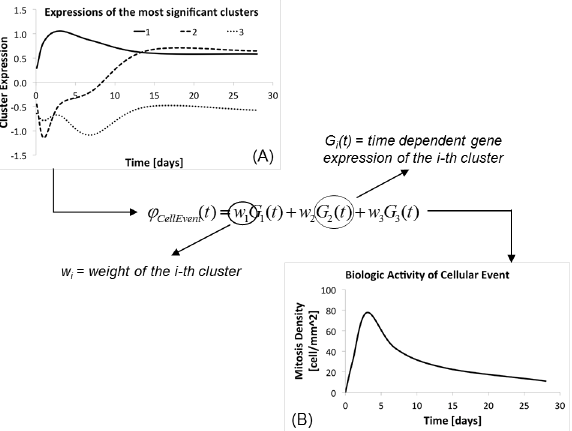
Fig 6. Calibration of the clusters’ weights. The temporaldynamic of a generic cellularevent (B) is describedwith a linear combination of the clusters of expressionontologically related to it (A). The level of impact that a generic cluster (G i (t)) employs on the cellularevent ( φ (t)) is mediatedthrough its relativeweight (w i ).